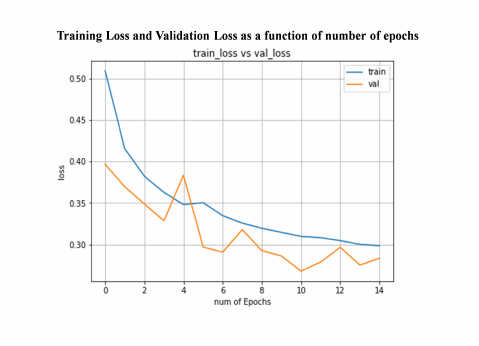
Figure 15: Training loss, validation loss as function of number of